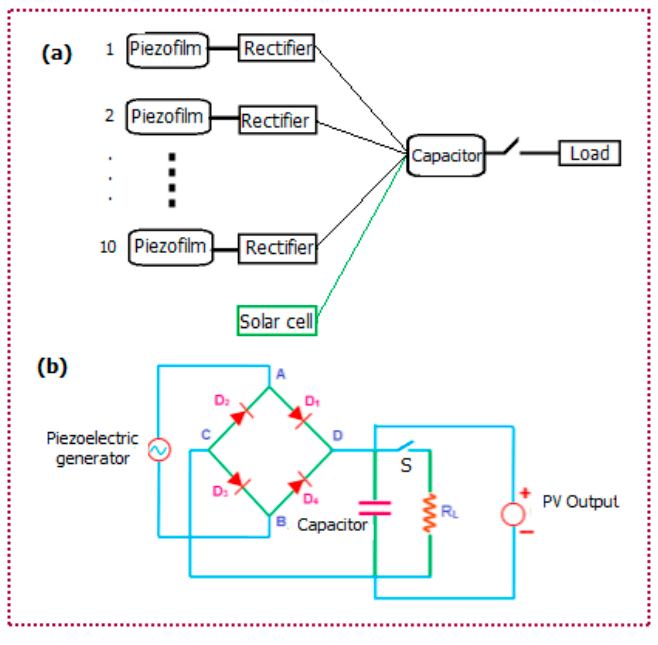
Figure 4. Circuit for the integration of the power output of the TSHG ( a ) logic diagram ( b ) power management circuit.